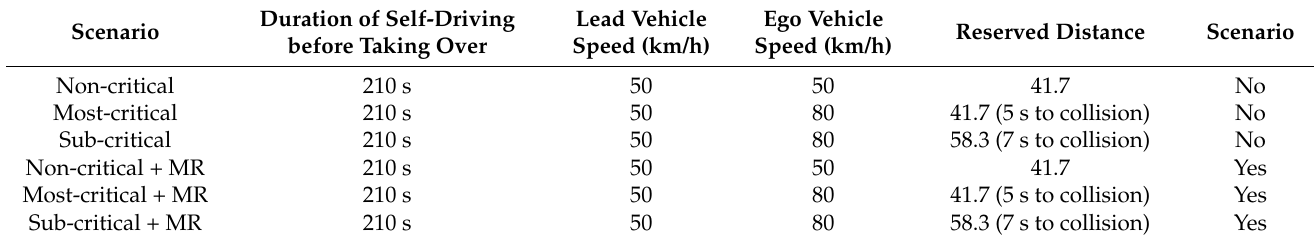
Table 1. Indicators of six driving